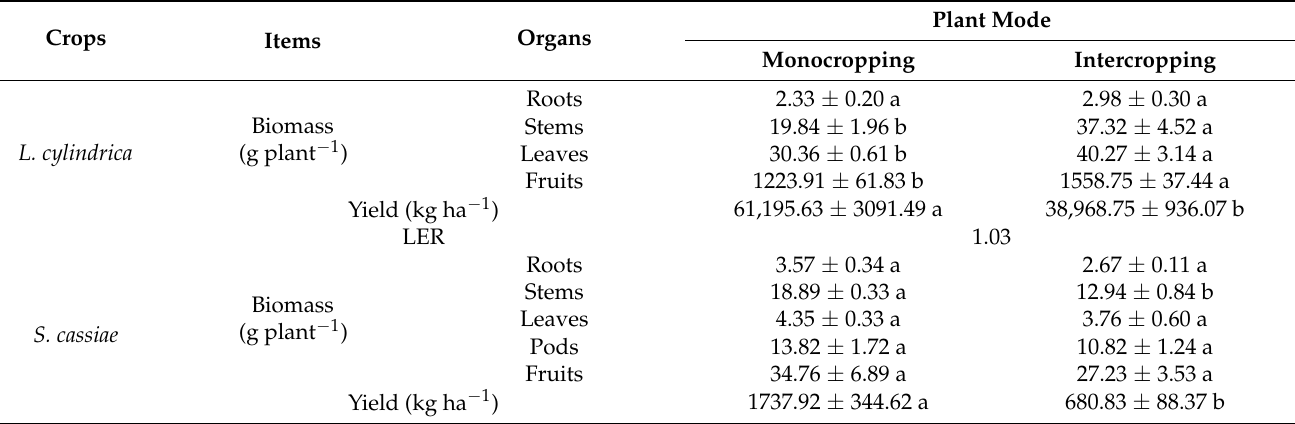
Table 1. Biomass and yield of L. cylindrica and S. cassiae under monocropping and intercropping systems in the field